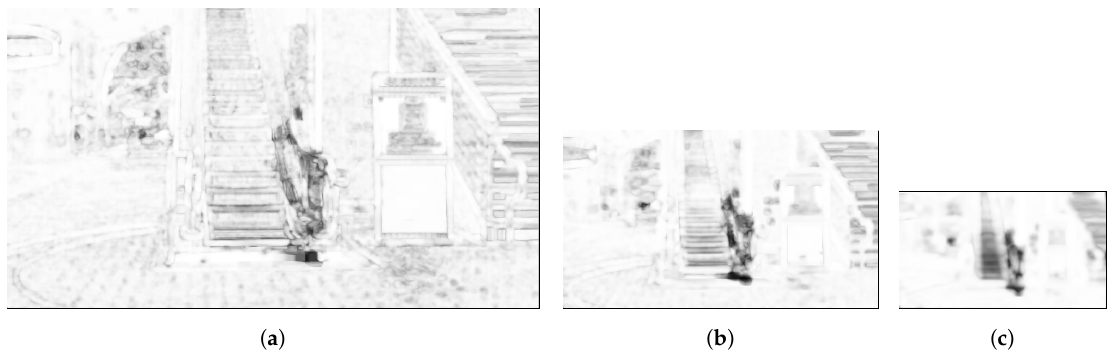
Figure 6. Structure Index ( SI ) map with nhood = 17 for the background image reconstructed using the method in [12] as shown in Figure 4b. The darker regions indicate larger structure differences between the reference and the reconstructed background image. ( a ) Scale l = 0; ( b ) Scale l = 1; ( c ) Scale l =